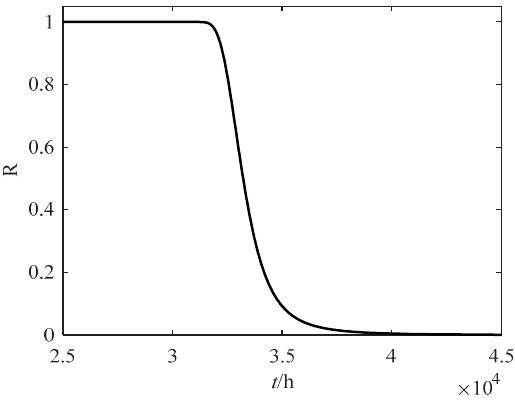
Figure 5. Reliability function of accelerometersat 20 °C.